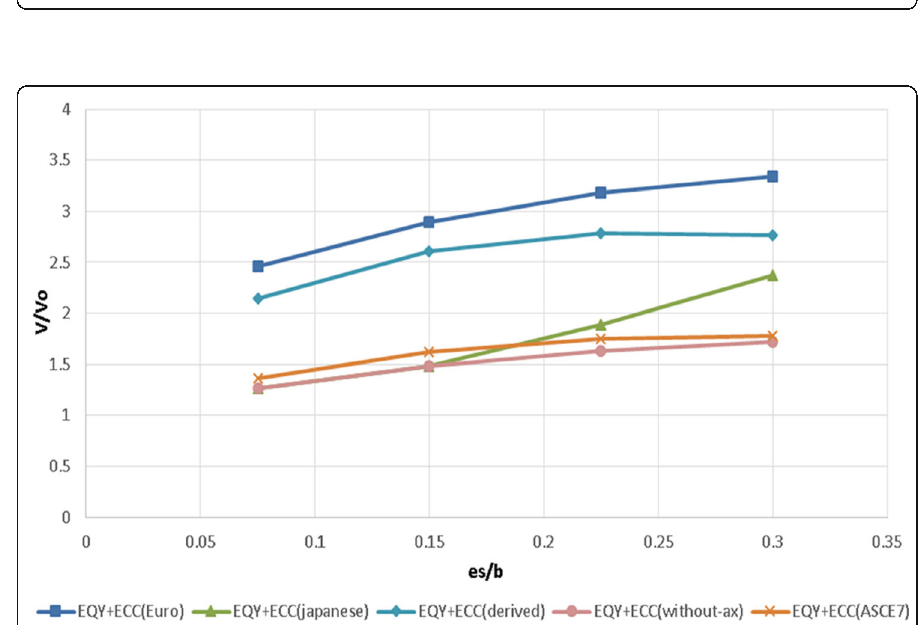
Fig. 43 Comparison of eccentricity ratio — design force ratio (design force in un-symmetric model V o , normalized by Design Force in symmetric plan V ) for flexible side elements for ASCE 7-16, EC-8, Japanese derived equation, and without considering torsional